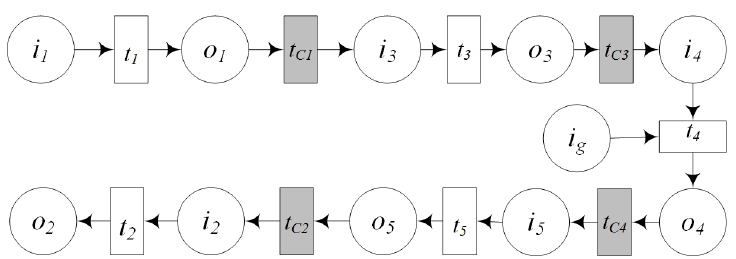
Figure 16. CPN model of the automatic firefighting